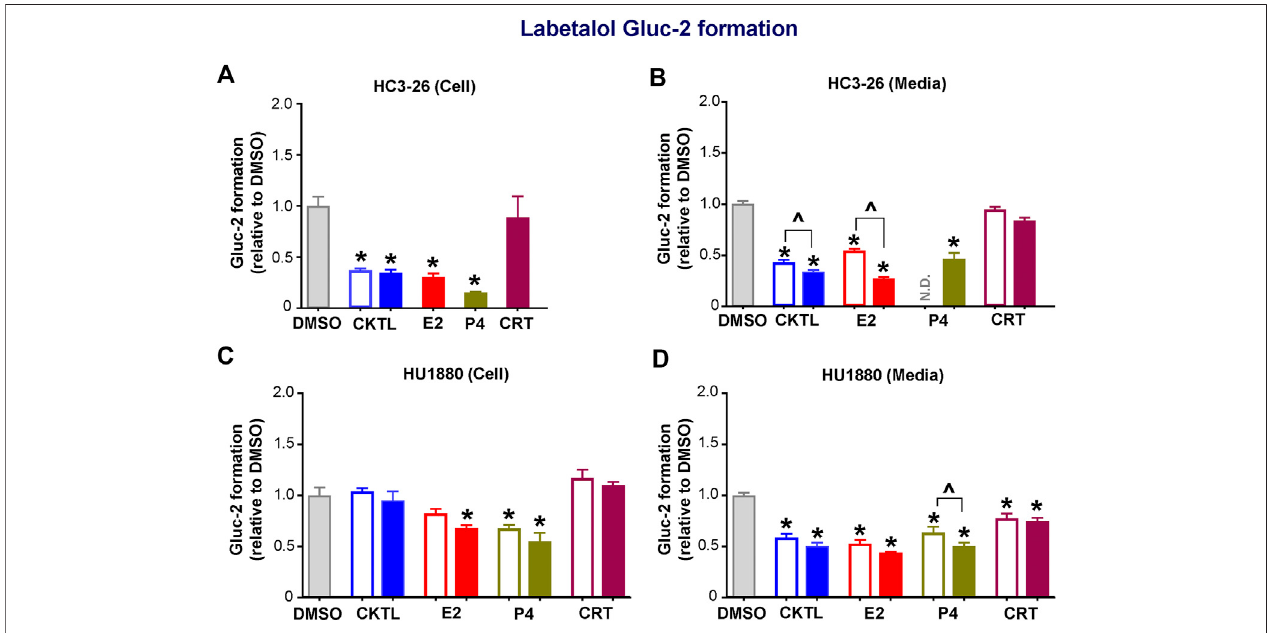
FIGURE5| Effectofpregnancy-relatedhormones(PRH)onlabetalolglucuronide(Gluc-2)formationinSCHH.Following72 hofPRHexposure,SCHHfromtwodonors (HC3-26,HU1880) wereincubatedwithlabetalol(1 mM)for 4 h. Labetalol glucuronide (Gluc-2)peakareawasmeasured inbothSCHHcelllysates (A, C) and SCHHmedia (B, D) , normalized to internal standard (labetalol-d 3 ) peak area in each sample, and compared across treatment groups in donor HC3-26 (A: cell lysate, n (cid:2) 3 per group; B: media, n (cid:2) 3 – 6 per group) and donor HU1880 (C: cell lysate, n (cid:2) 4 per group; D: media, n (cid:2) 4 per group). In the donor HC3-26 experiment, cell lysates were not harvestedforglucuronidemeasurementsinthe1 µME2,P4,orCRTgroups.Dataarecalculatedasthefold-changeinGluc-2metaboliteformationrelativetovehiclecontrol (* p < 0.05 vs. DMSO). Concentration-dependent effects were assessed (open bar: 1 μ M, solid bar: 10 μ M; ^ p < 0.05 1 vs. 10 µM). N.D., experimental group not